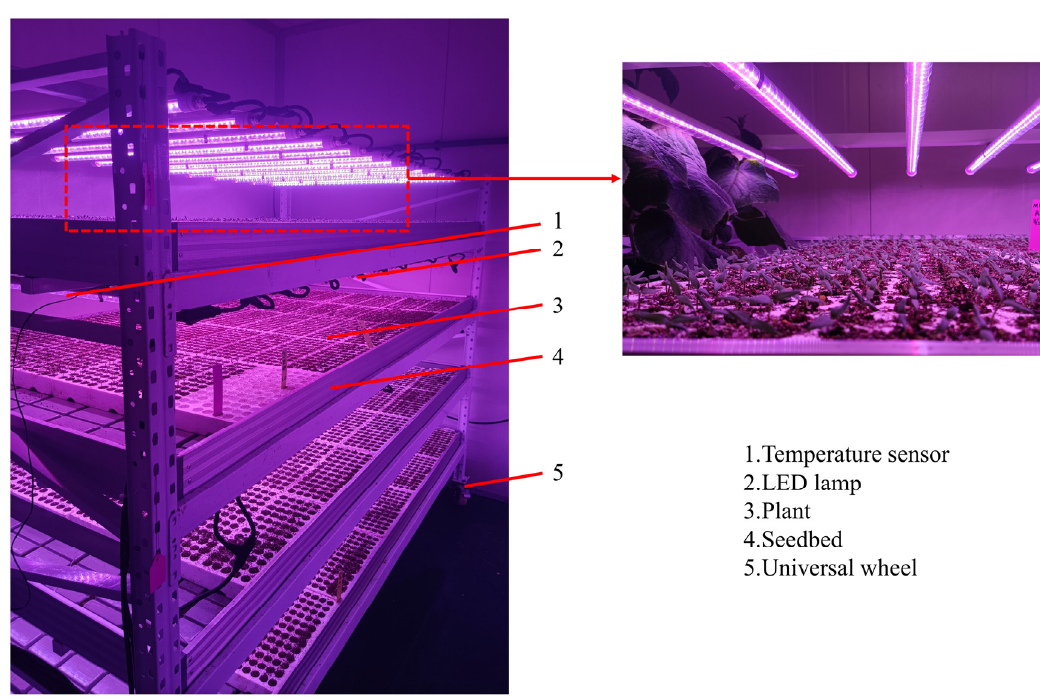
Figure 1. Spectral distribution of LEDs.